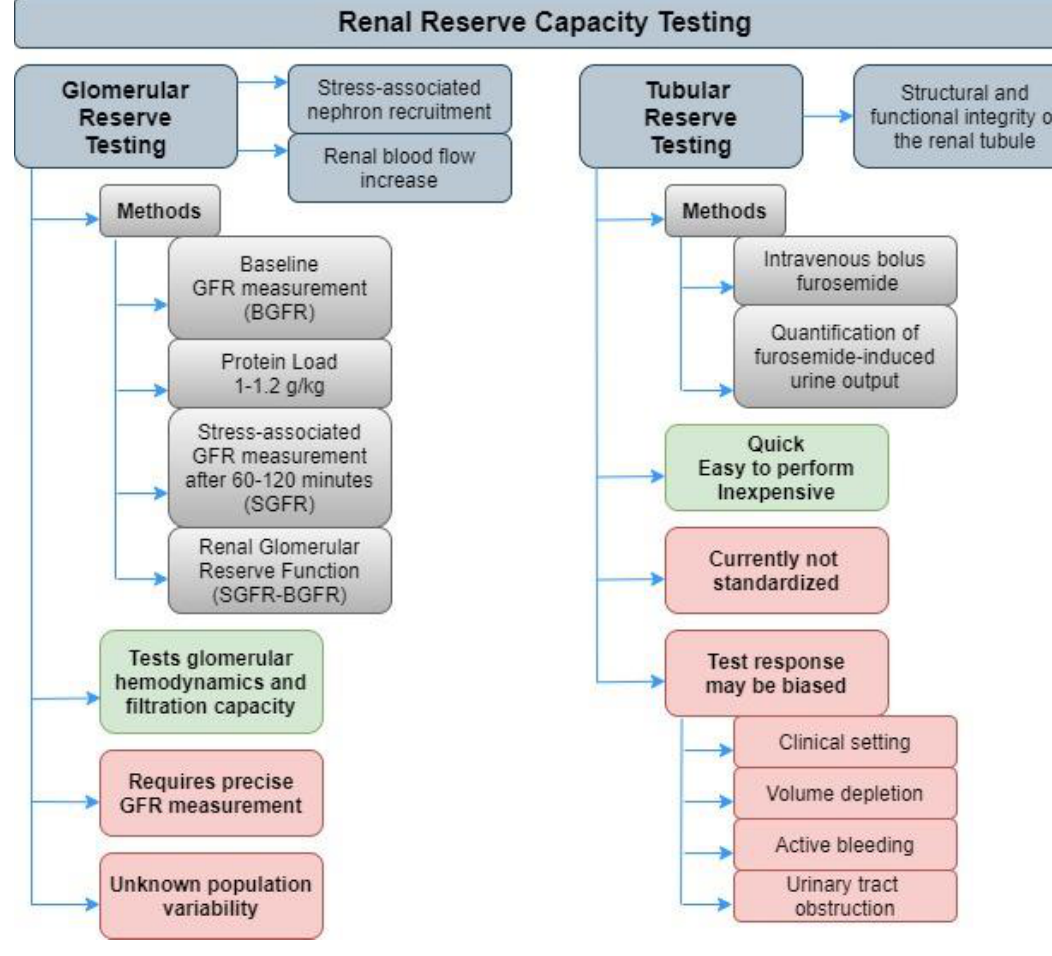
Figure 1. Renal reserve capacity testing.